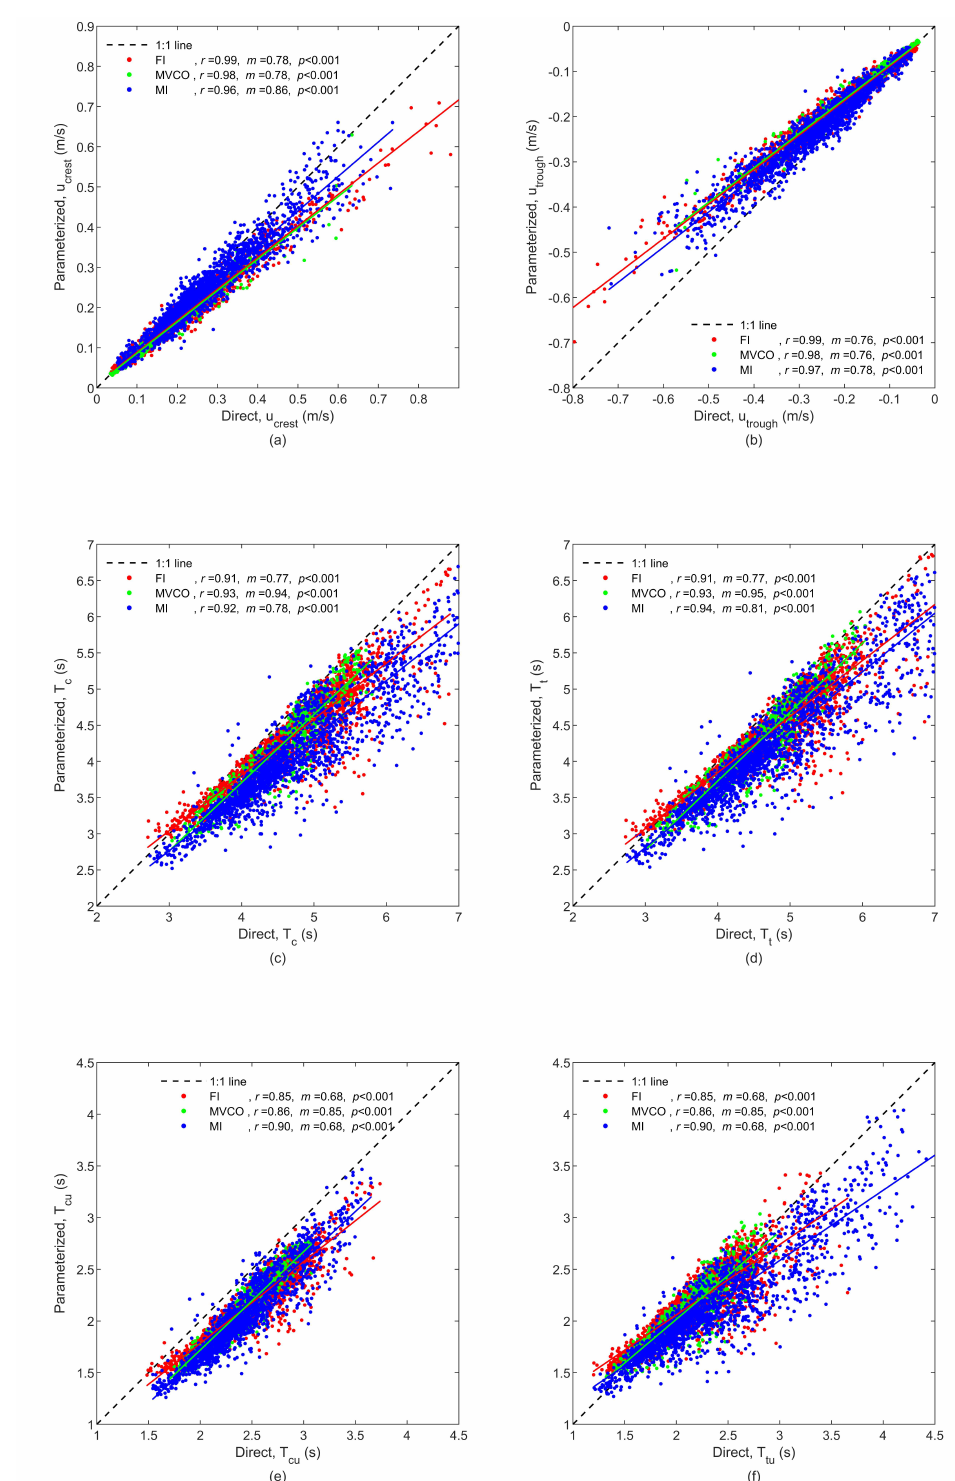
Figure 6. Scatter plot showing a comparison of ADV based direct measurements and surface wave spectrum based parameterized measurements ( a ) peak crest cycle velocity, u crest (m/s); ( b ) peak trough cycle velocity, u trough (m/s); ( c ) crest cycle period, T c (s); ( d ) trough cycle period T t (s); ( e ) crest cycle accelerative period ( T cu ) , (s); and ( f ) trough cycle accelerative period, T tu (s). The dashed black line shows an identity line and solid-colored lines correspond to site-specific linear fit to data